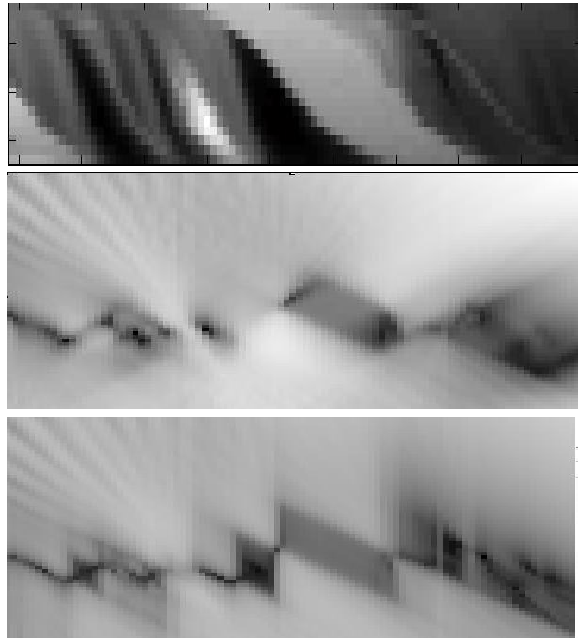
Figure 5. Top: epiplanar slice in the (u,t) direction. Middle: associated full profile cost in the (u,s) direction. Bottom: associated right profile cost in the (u,s) direction. For costs, dark values show small residues and bright values show high